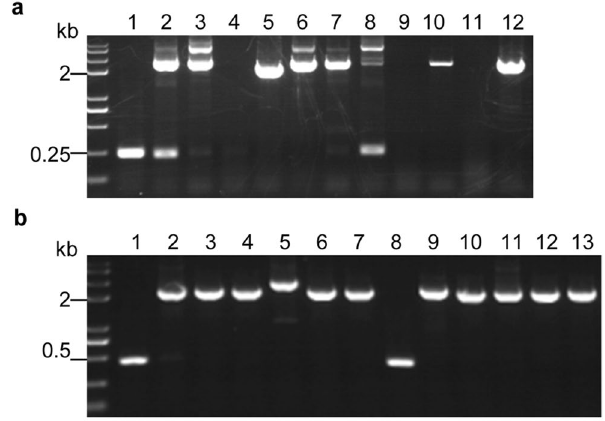
Figure 4. The newly established CRISPR-Cas9 system functions well in A . oryzae NSAR1 and S . minima (No. 40-1-4-1). ( a ) Targeted disruption of wA in A . oryzae . NSAR1 (1: JA1001; lane 2-12: argB -resistance clones (No. 1-11)). ( b ) Targeted disruption of HdaA in S . minima (No. 40-1-4-1). (1: JS1001; lane 2-13: G418-resistance clones (No.